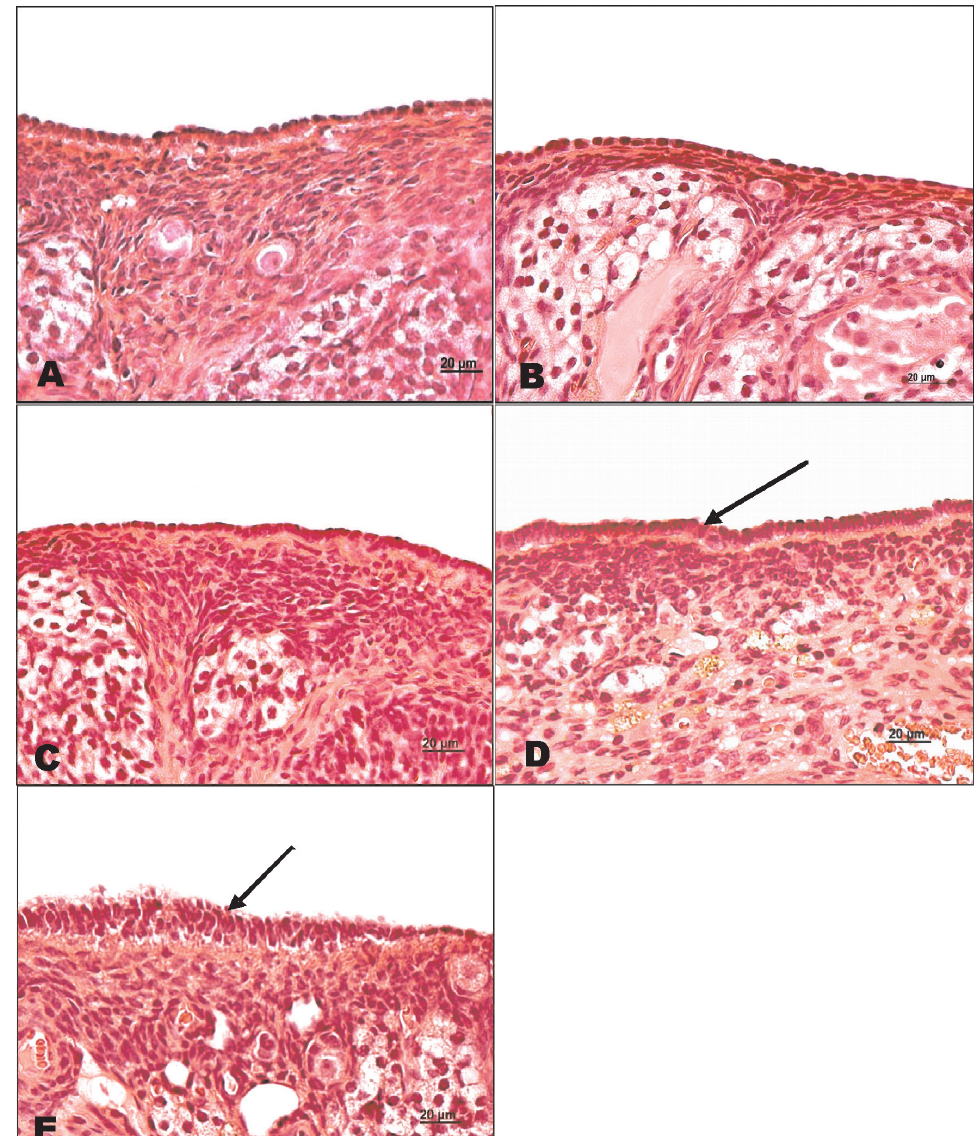
Figure 2 - Photomicrography showing the cortical region of ovaries belonging to the different study groups: A) GPROP, B) GE50µg, C) GE0.5mg, D) GE1mg and E) GE2mg. The arrows in (D) and (E) indicate thickened superficial epithelia. H.E